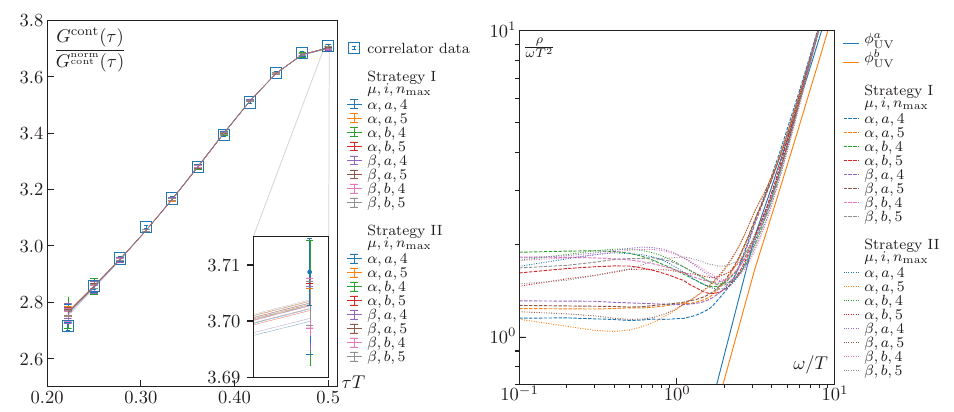
Figure 1. Left: Model correlators obtained from integration of the model spectral functions. The labels distinguish between di ff erent models (see Eq. (4)). Right: Model spectral functions from fits of the correlator data for all considered models. Statistical errors are hidden for better visibility; for ω = 0 they can be found in Fig. 2, all others can be found in the data publication